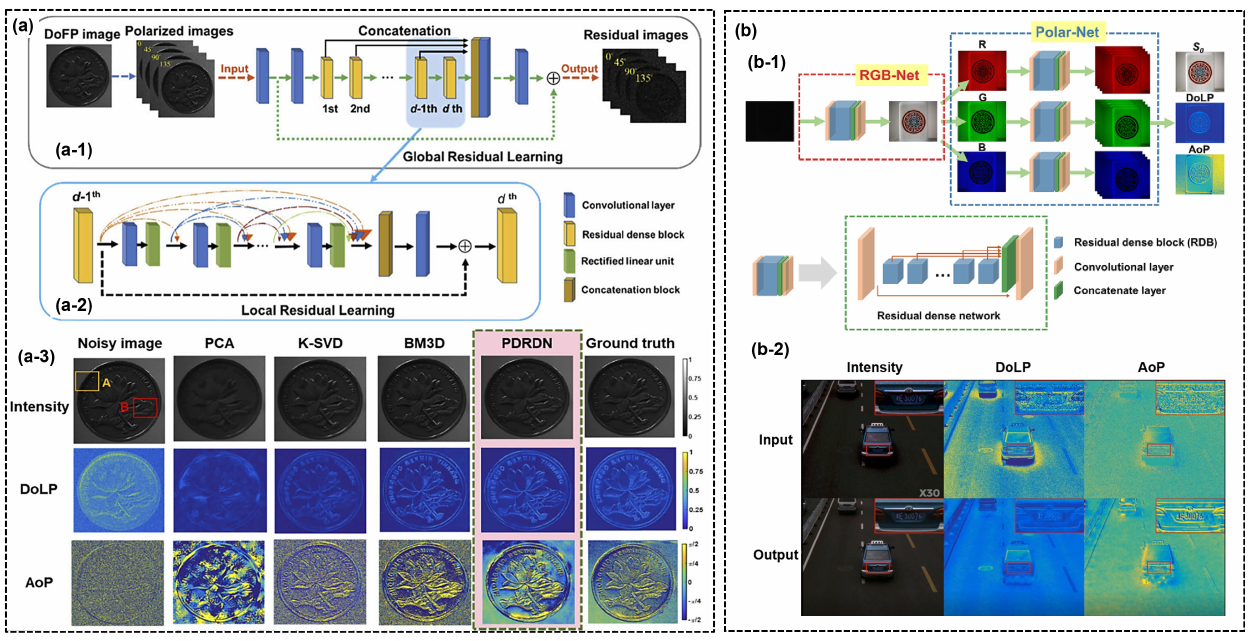
Figure 13. ( a ) DL-based denoising for visible polarimetric images [5]: ( a-1 ) Network architecture; ( a-2 ) Residual Dense block; ( a-3 ) Restored results comparison. ( b ) Denoising for chromatic polariza- tion imagers in low-light [11]: ( b-1 ) Network architecture; ( b-2 ) Restored results in